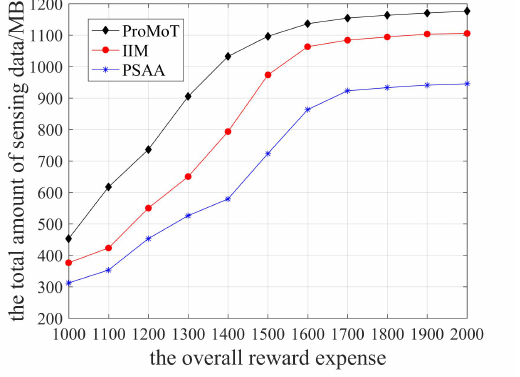
Figure 8. The total volume of sensing data.